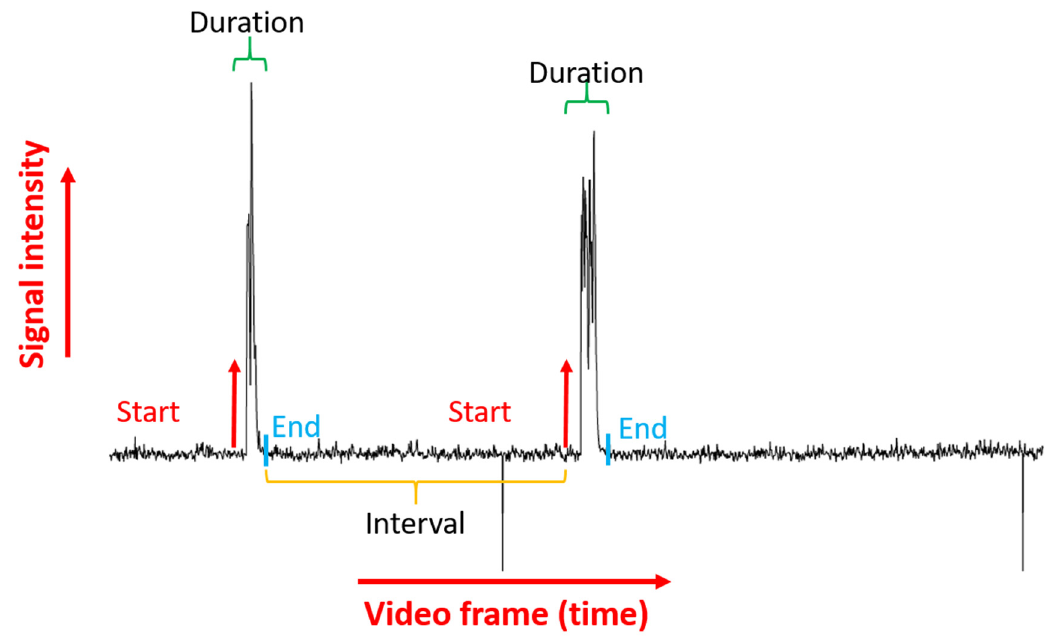
Figure 6. Start and end threshold set for tail coiling occurrence duration and the interval between tail coiling occurrence. Some important endpoints such as tail coiling interval and tail coiling duration can also be extracted from the raw signal intensity over time data.